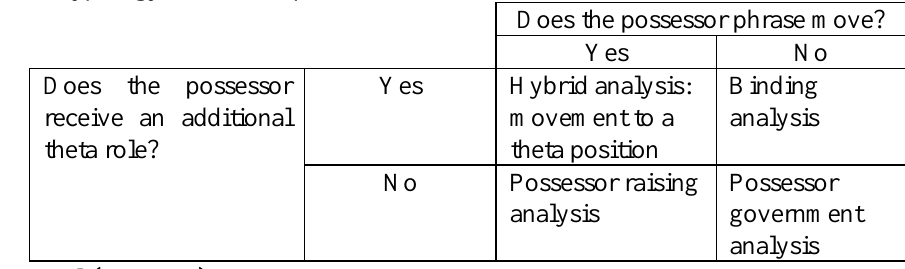
Does the possessor phrase move? Yes Yes Hybrid analysis: Binding movement to a analysis theta position No Possessor raising Possessor analysis government